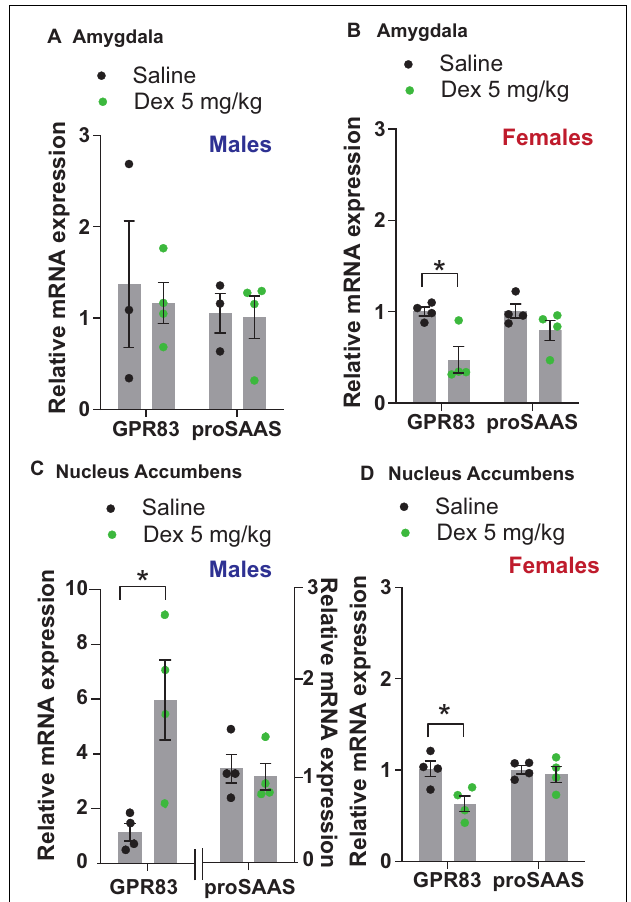
FIGURE 4 | GPR83 expression is regulated by dexamethasone in the amygdala and nucleus accumbens in a sex-dependent manner. (A,B) Administration of dexamethasone (5 mg/kg) decreases expression of GPR83 in the amygdala of female mice but not males with no effects on proSAAS expression. (C,D) In the NAc, administration of dexamethasone increases expression of GPR83 in males and decreases the expression in females. The proSAAS expression is unchanged in all cases. Data are represented as mean ± SEM and analyzed using unpaired t -test, * p < 0.05, n = 3–4 per